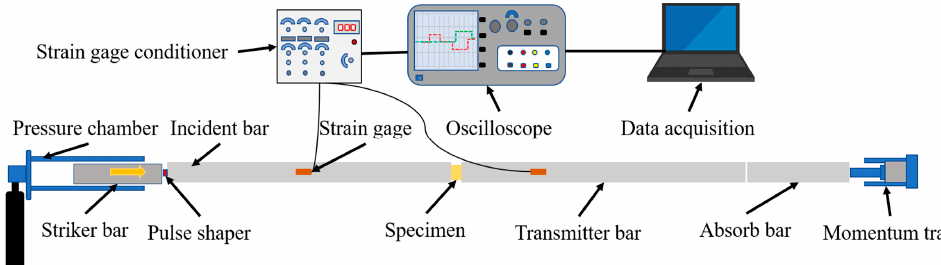
Figure 1. Schematic of the Split Hopkinson pressure bar set up for high strain rate testing.